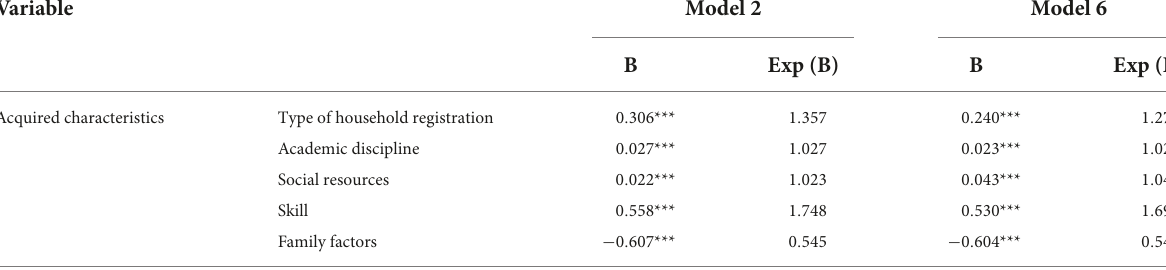
TABLE 4 Results of regression analysis of acquired characteristics factors on the dependent variable.